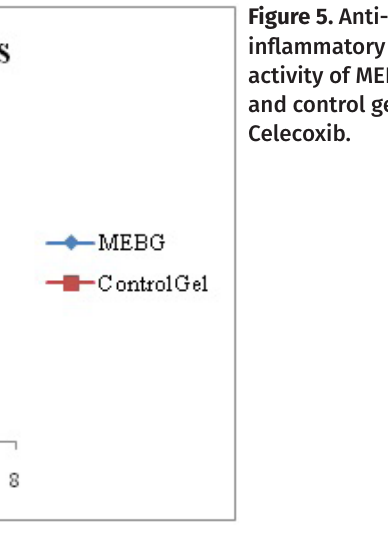
Figure 5. Anti- inflammatory activity of MEBG and control gel of